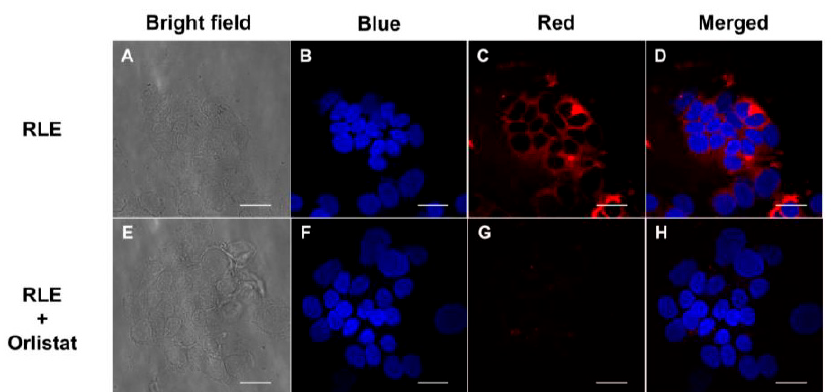
Figure 4. Imaging in live AR42J cells. ( A – D ) AR42J cells incubated with RLE (15 µM) and Hoechst 33,342 (5 µg/mL) for 20 min. ( E – H ) Colocalization images of live AR42J cells costained with RLE (15 µM) after treatment with orlistat (25 µM) for 15 min. Scale bars = 25 µm. Blue channel for Hoechst 33,342, 420–480 nm; red channel for RLE, 580–600 nm.